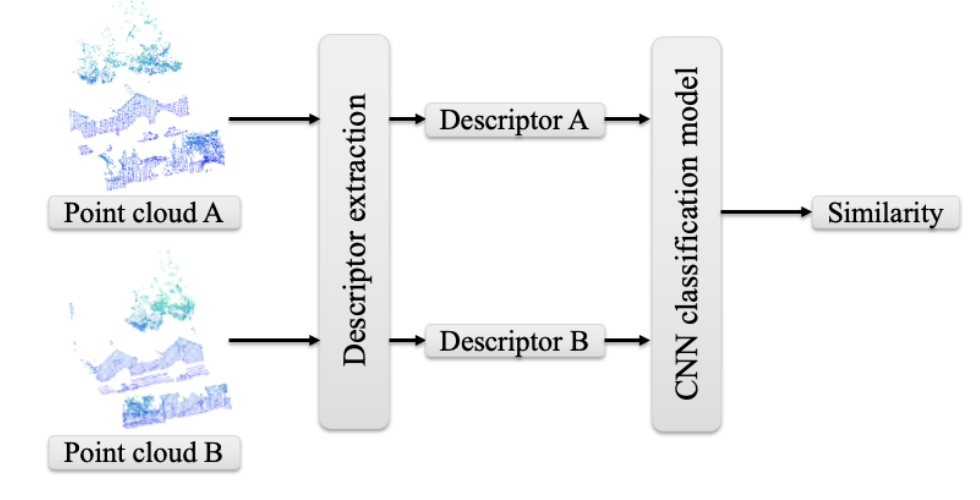
Figure 1. Proposed network for PR task